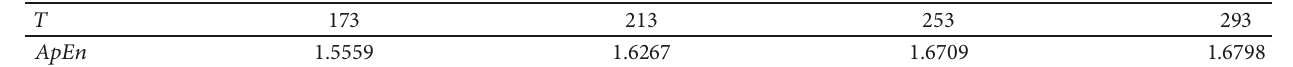
Table 2: The ApEn of {𝑑𝑈 𝑖 /𝑑𝑡, 𝑖 = 1, 2,⋅ ⋅⋅ , 𝑁} for different